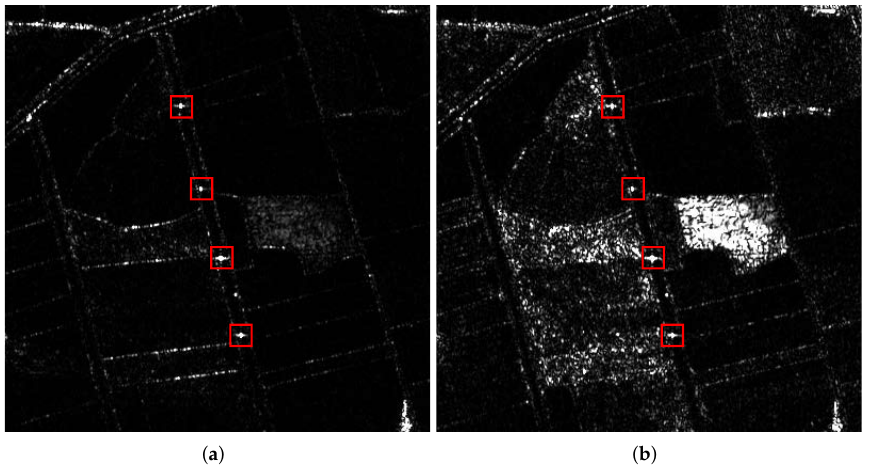
Figure 13. Enlarge intensity image of L-band airborne HCP data in Boao, Hainan province,